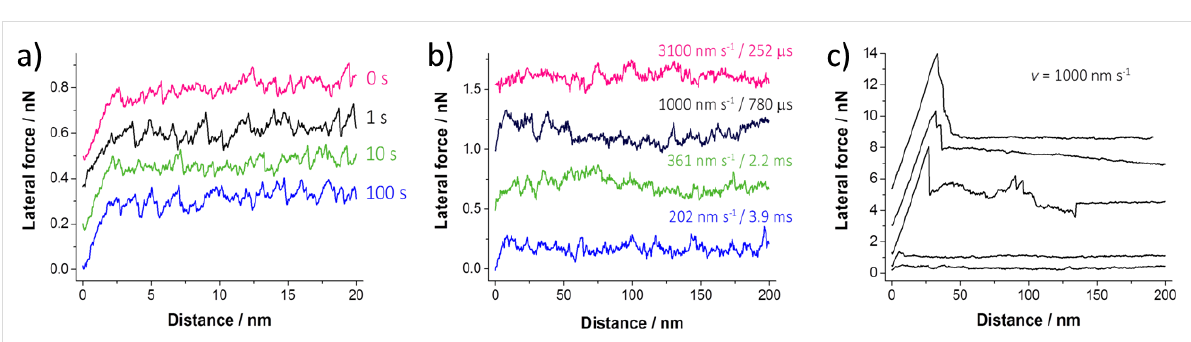
Figure 2: Graphs exemplifying the absence of contact ageing for slide–hold–slide experiments under UHV conditions. All curves are offset for better clarity. a) Variation of the holding times (0–100 s) for a SiO x /Si tip sliding against a Au(111) surface. The static friction did not exceed the kinetic fric- tion for any holding time. b) Variation of scanning velocity and, thus, of the holding time at the turning points (252 μ s to 3.9 ms) for a SiO x /Si tip sliding against an oxidized Si(100) surface. c) Examples for irregularly large stick–slip events observed during scanning, prevalently at the turning points of the scanning movement. Scan lines are extracted from various positions of two scan frames for a SiO x /Si tip sliding against an oxidized Si(100) sur- face at a sliding velocity of 1 μ m·s − 1 . The line with the lowest friction corresponds to the black line in Figure 2b. The kinetic friction remained in- creased after large stick–slip